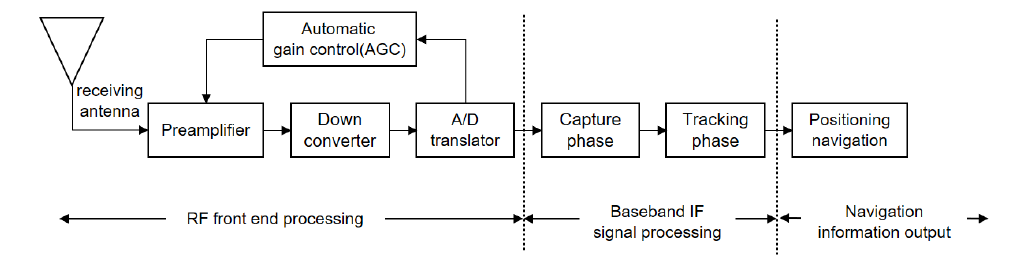
Figure 5. Typical GNSS receiver